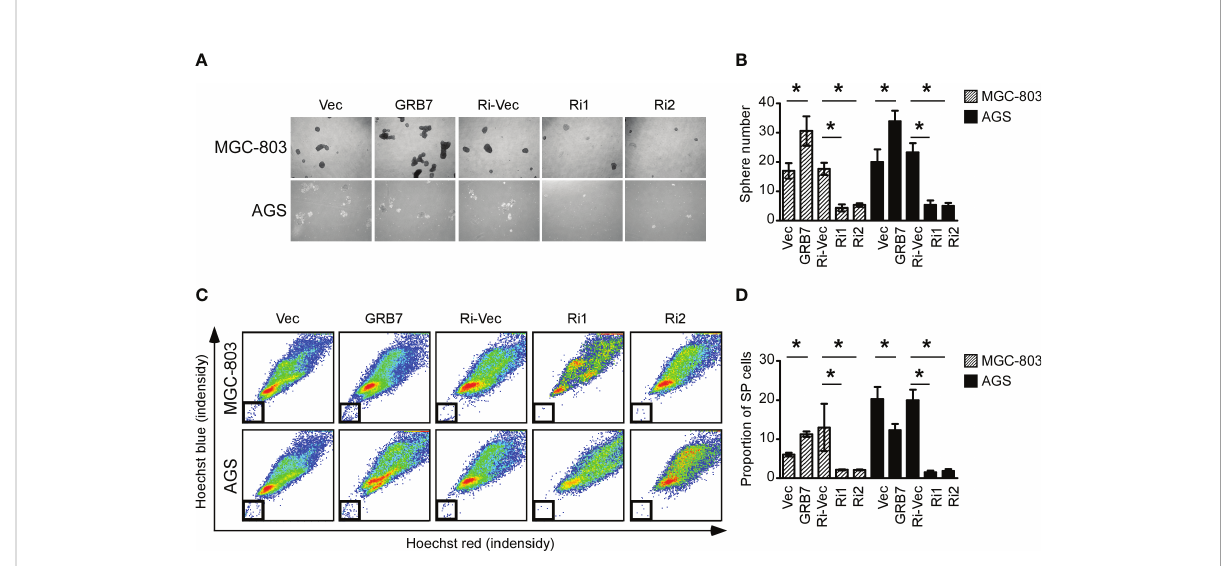
FIGURE 5 GRB7 positively correlates with the self-renewal potential of gastric cancer cells. (A , B) The representative pictures and statistical chart of the sphere formation assay showed that the expression of GRB7 is positively correlated with the number of spheres (mean ± SD). *P < 0.05. (C, D) Side population stem cell sorting assay revealed that the proportion of SP cells was positively correlated with the expression of GRB7. *P <